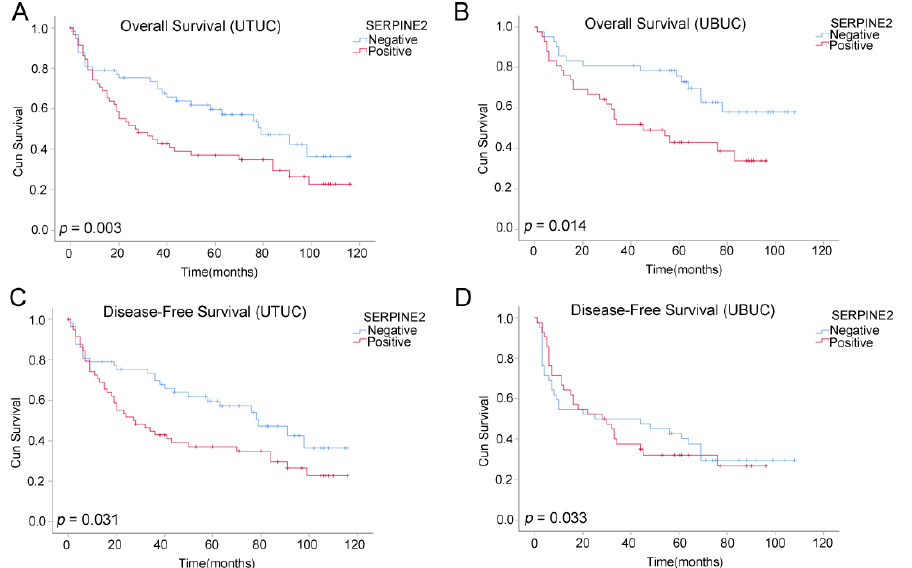
Figure 4. ( A , B ) Overall survival and ( C , D ) disease-free survival rates according to SERPINE2 immunoreactivity in both upper tract and bladder urothelial carcinoma. Table 2. Univariate and multivariate analysis of SERPINE2 in OS of 117 UTUC patients. Univariate Multivariate